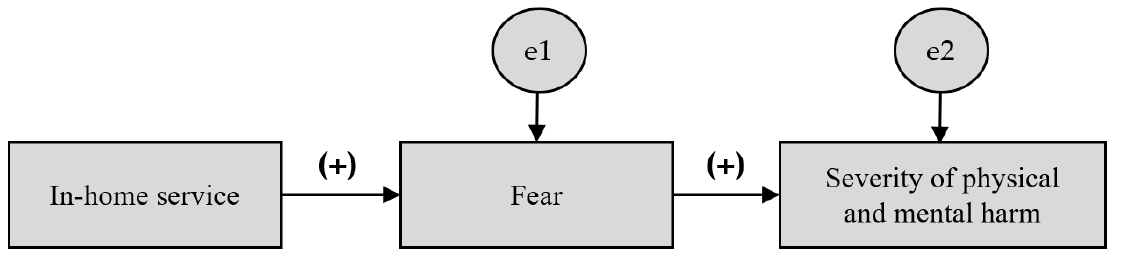
Figure 1. Conceptual framework for this study. Analysis of the difference between the group as a whole and the group with permanent employment and the group with non-permanent employ- ment.